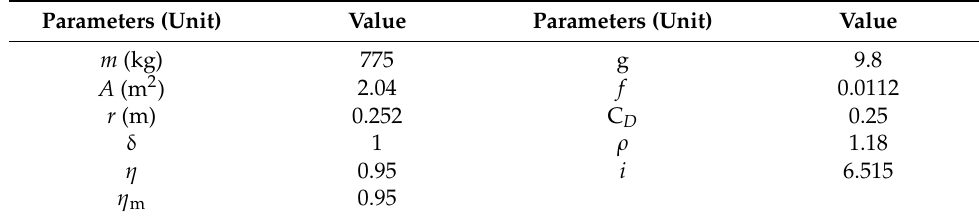
Table 1. Simulation parameters.